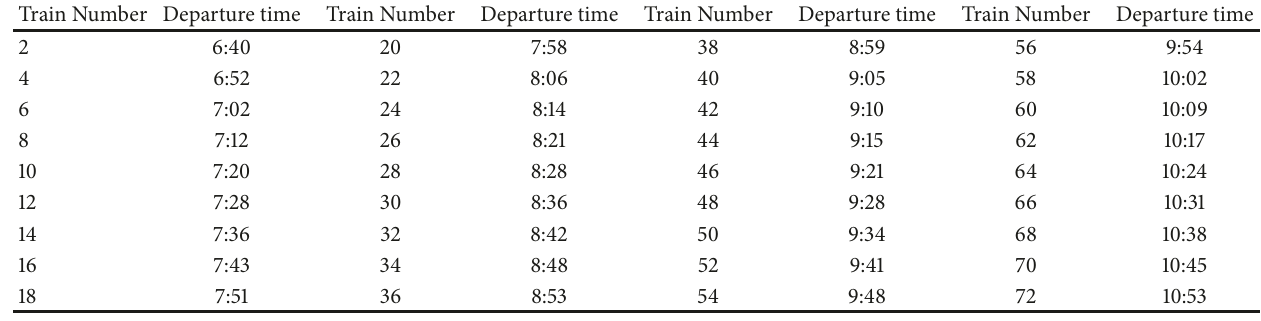
Table 3: Departure time at the starting station for down trains.